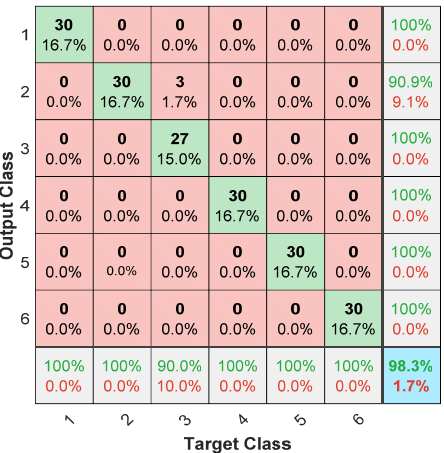
Figure 12. Confusion matrix of the IGOA-PNN recognition results.